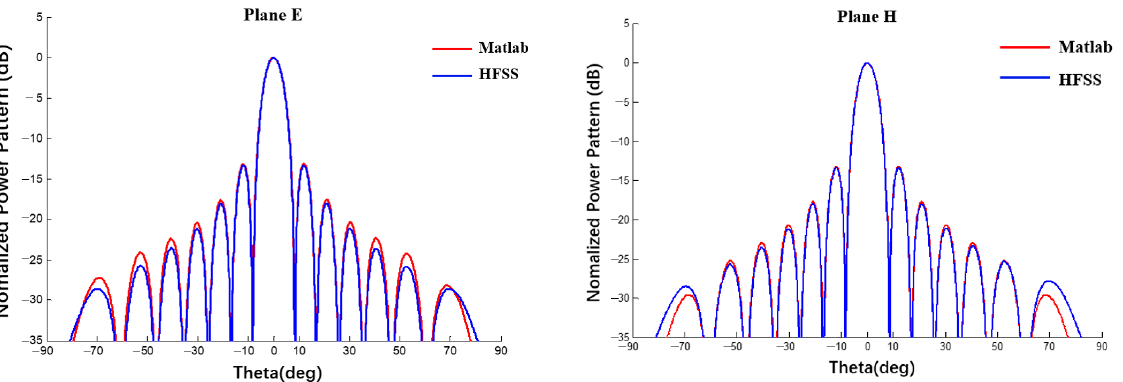
Figure 10. Simulation of 10 × 10 array antenna contrast pattern using MATLAB and HFSS (uniform excitation).